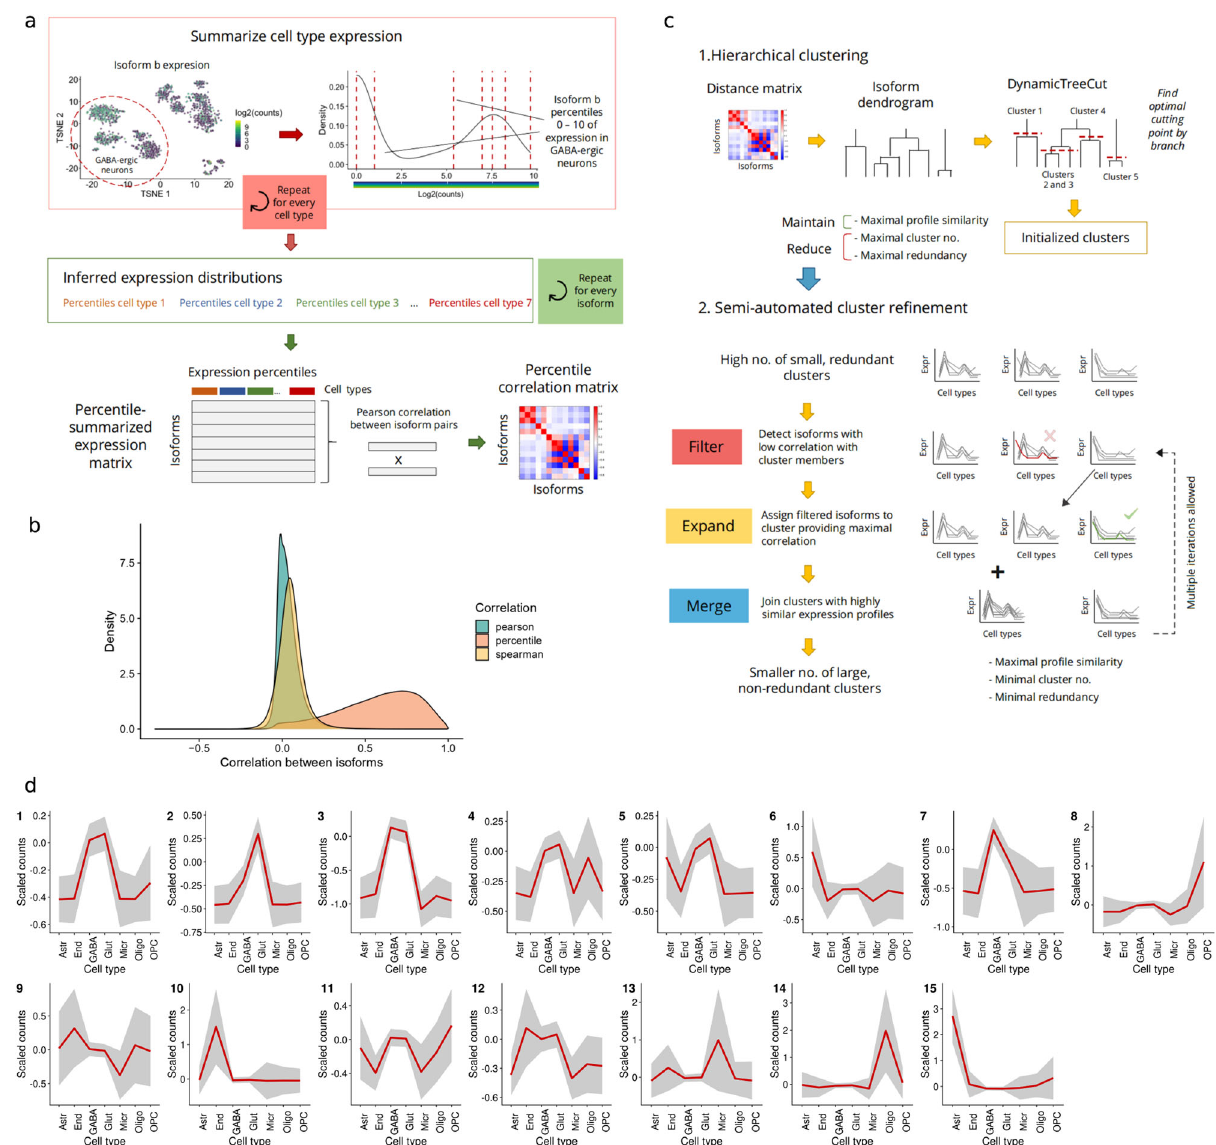
Fig. 2 Percentile correlations and isoform clustering. a Percentile correlation algorithm. For each isoform, cell type-level expression is summarized using percentiles (0 – 10) as a proxy of the isoform ’ s expression distribution in each of the cell types. Then, Pearson correlations are computed using the percentile-summarized expression of all isoforms, obtaining a percentile correlation matrix. b Correlation density distributions. Pairwise isoform correlations were computed using Pearson, Spearman, and percentile + Pearson correlation. c Clustering pipeline. The percentile correlation matrix is fi rst used as a distance matrix for hierarchical clustering. After dynamic cluster generation, noisy clusters are re fi ned by a three-step semi-automated process. d Clusters generated after applying the acorde clustering pipeline to the mouse neural dataset. Cell-level mean expression (scaled, see “ Methods ” ) is computed for all transcripts and then aggregated as the global cell type mean, represented by the red line. Gray area corresponds to cell type mean ± standard deviation. Astr: astrocytes, End: endothelial cells, GABA: GABA-ergic neurons, Glut: glutamatergic neurons, Micr: microglia, Oligo: oligodendrocytes, OPC: oligodendrocyte precursor